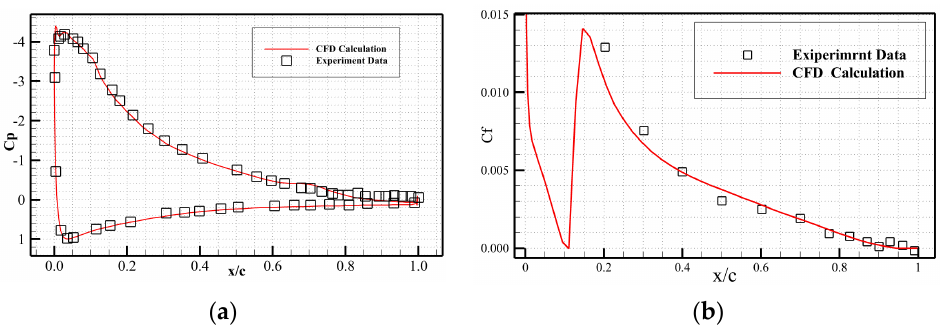
Figure 3. Verification of pressure and surface friction distribution. ( a ) Pressure distribution; ( b ) Friction coefficient distribution.